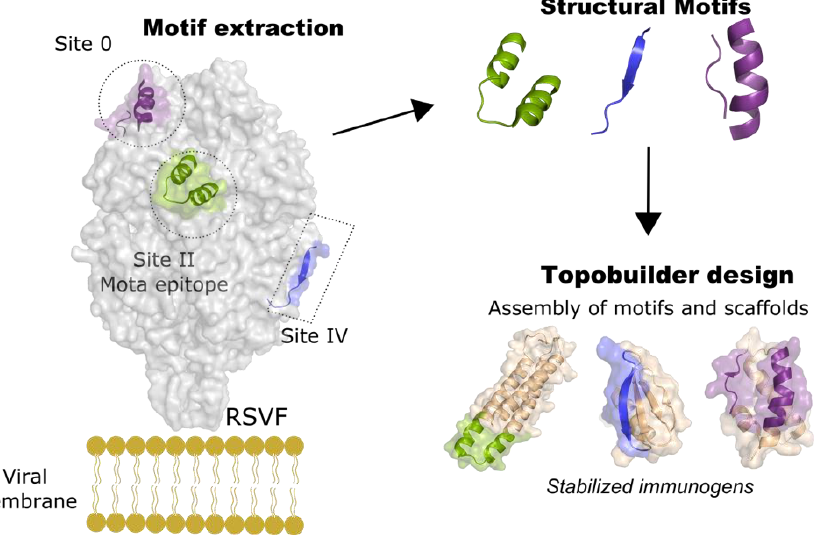
Figure 4. Strategy for de novo design of a trivalent epitope-focused vaccine. The neutralizing sites 0, II, and IV of RSV F were stabilized by de novo designed scaffolds using Topobuilder [121]. Topobuilder aided the construction of specific topologies that stabilize the antigenic motifs of the RSV F protein. Subsequent design and folding simulations yield stable immunogens that were used to generate a tri-scaffold vaccine. The combination of three scaffolds induced specific neutralizing antibodies against RSV F in nonhuman primates.